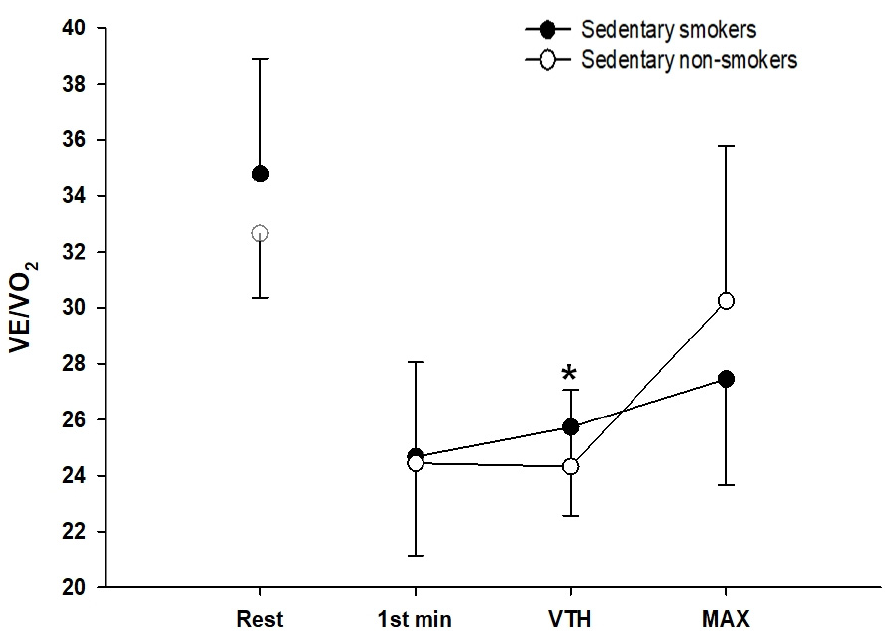
Figure 1. Ventilation Equivalents in O 2 (VE/VO 2 ) in sedentary smokers (black circles) ( n = 25) and sedentary non-smokers (white circles) ( n = 25). t -test for independent samples is used for analysis. Data represented at rest, first minute of exercise (1st min), ventilatory threshold (VTH), and maximal exercise (Max), respectively; * p < 0.05.